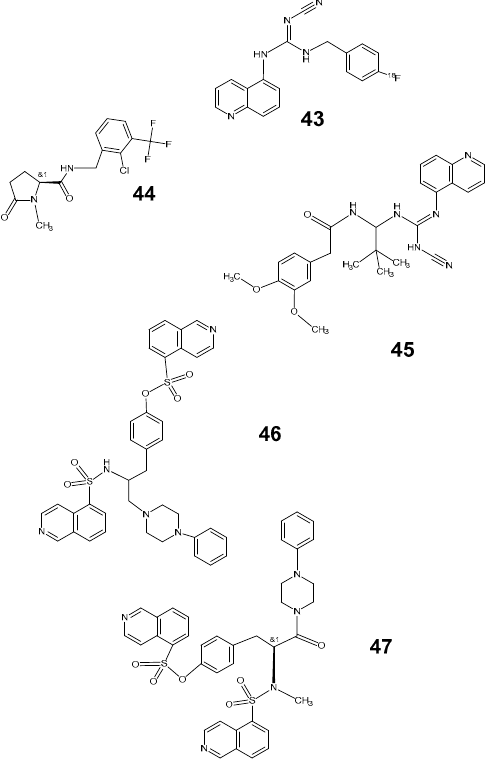
Figure 10. P2X7 receptor ligands 43 : [ 18 F] EFB; 44 : [ 11 C] GSK1482160; 45 : A-740003; 46 : KN04; 47 : KN62.